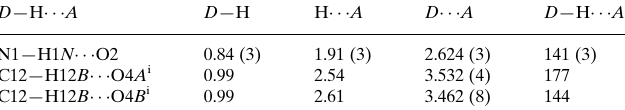
Hydrogen-bond geometry (A˚ , (cid:2)